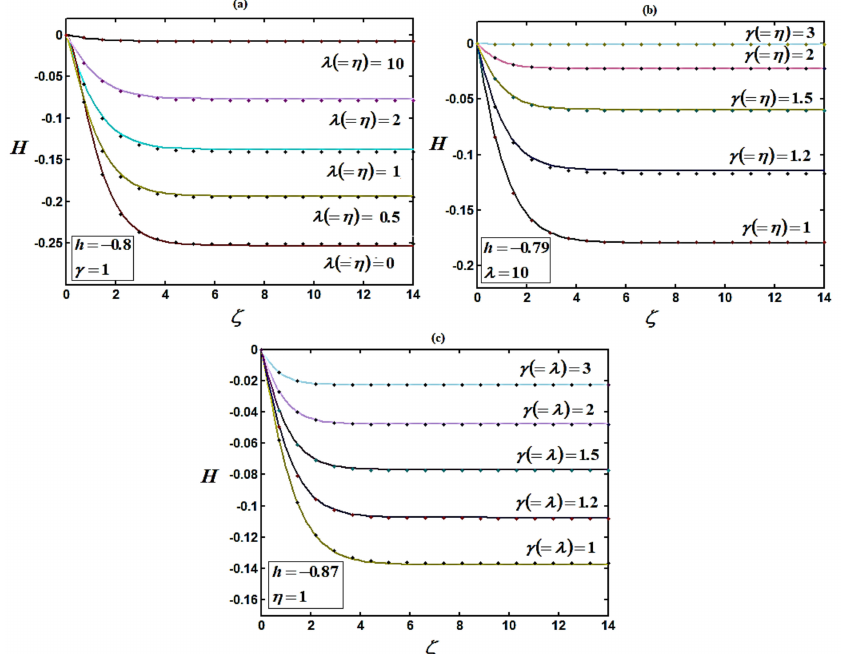
Figure 4. ( a – c ) Plots of the normalized axial velocity component H versus normalized distance from the disk ζ using Equation (15) for various values of parameters. Solid lines represent Equation (15) and dotted lines represent the numerical solutions